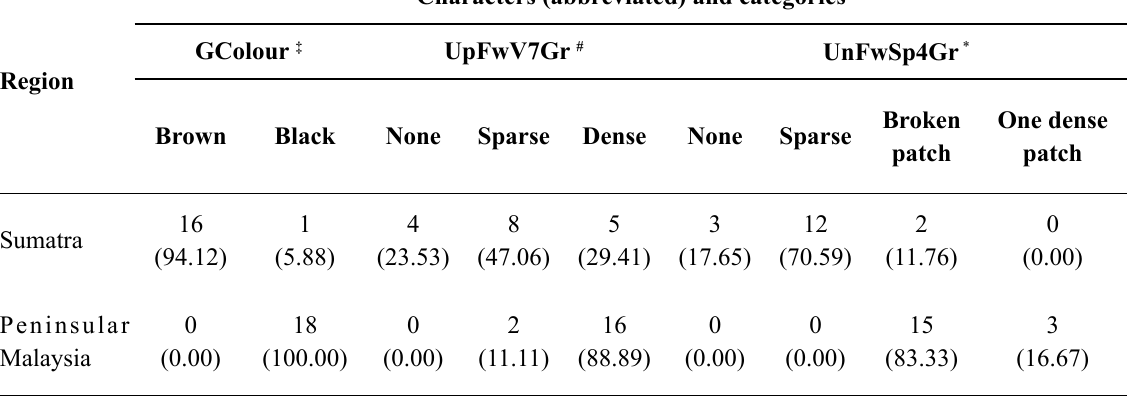
Table 4. Numbers and percentages (in parentheses) of females from Sumatra and Peninsular malaysia with each categorical